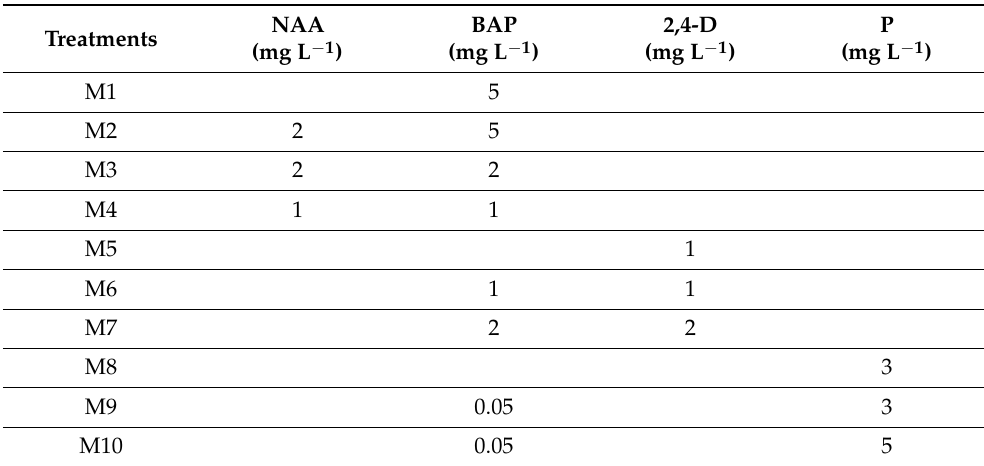
Table 1. Combinations of different growth regulators that were used in the medium (MS) to induce morphogenesis in ‘MD2 (cid:48) hybrid